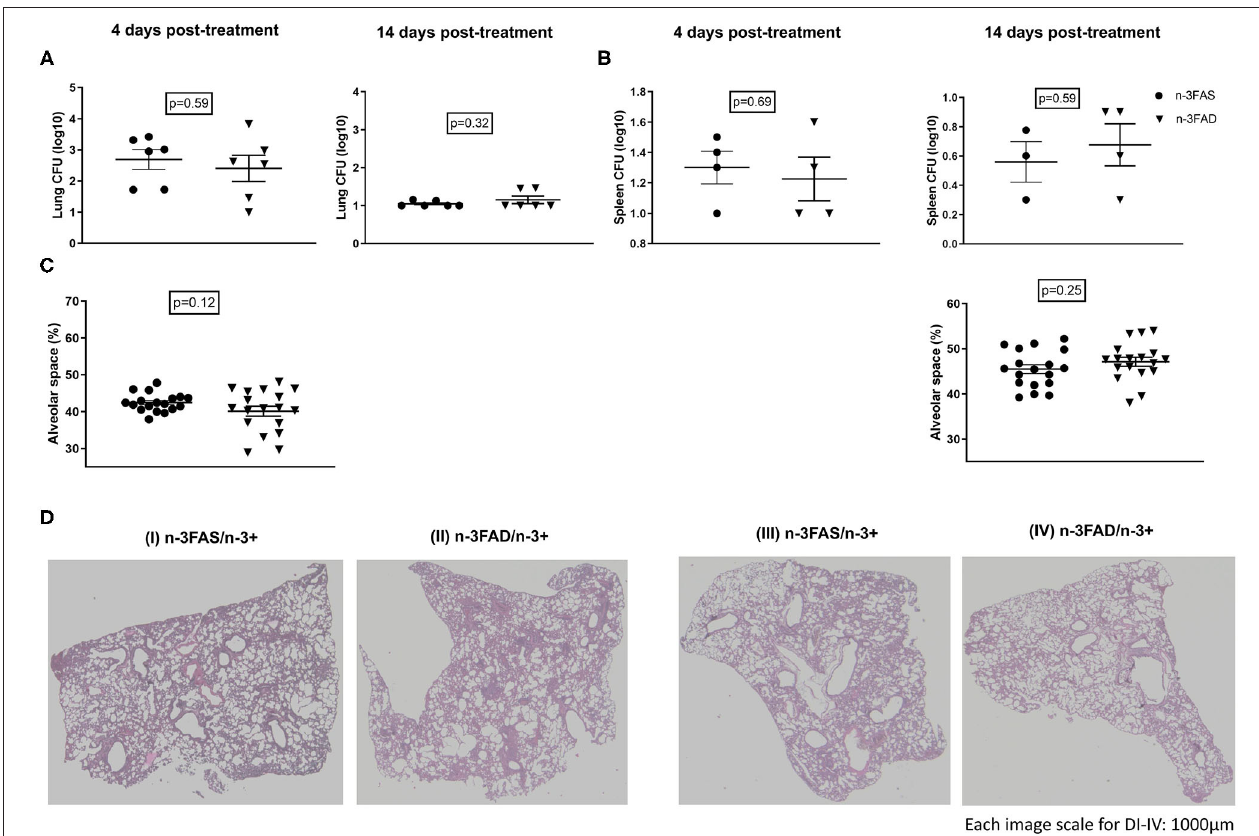
FIGURE 4 | Effect of treatments on lung bacillary load and lung histopathology according to fatty acid status. (A) Lung bacteria load, (B) spleen bacteria load, (C) percentage free alveolar space, and (D) hematoxylin–eosin-stained sections of the lungs of selected representative group, after 4 [ (D) (I,II)] and 14 [ (D) (III,IV)] days treatment period. The data represented as mean ± SEM of n = 6 mice/group and representative of two independent experiments. Unpaired two-tailed t -test was used to compare means, significance at * p < 0.05, ** p < 0.01, *** p < 0.001; n-3FAS, omega-3 fatty acid-sufficient diet group; n-3FAD, omega-3 fatty acid-deficient diet